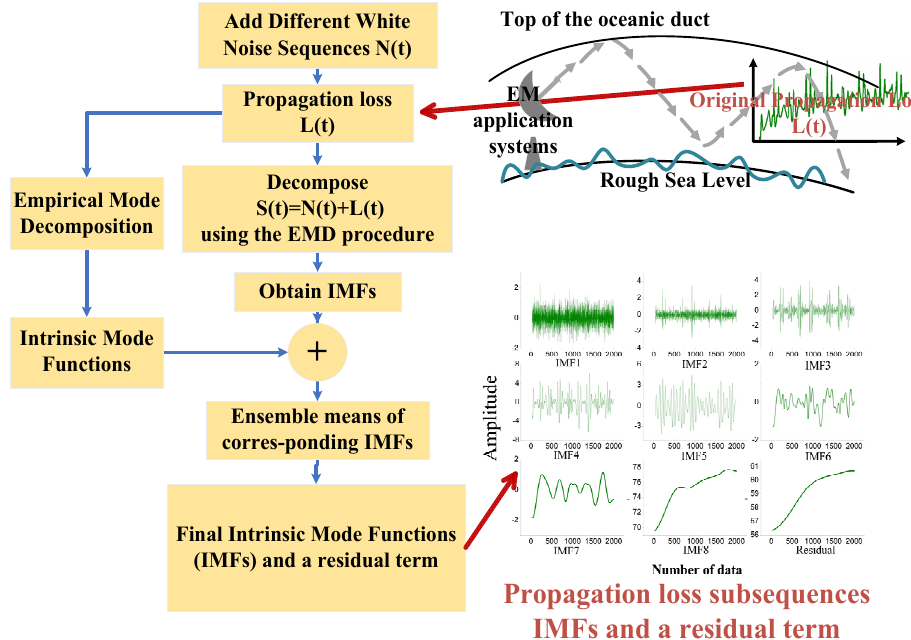
Figure 3. Preprocessing of propagation loss in an oceanic tropospheric duct based on ensemble empirical mode decomposition (EEMD).